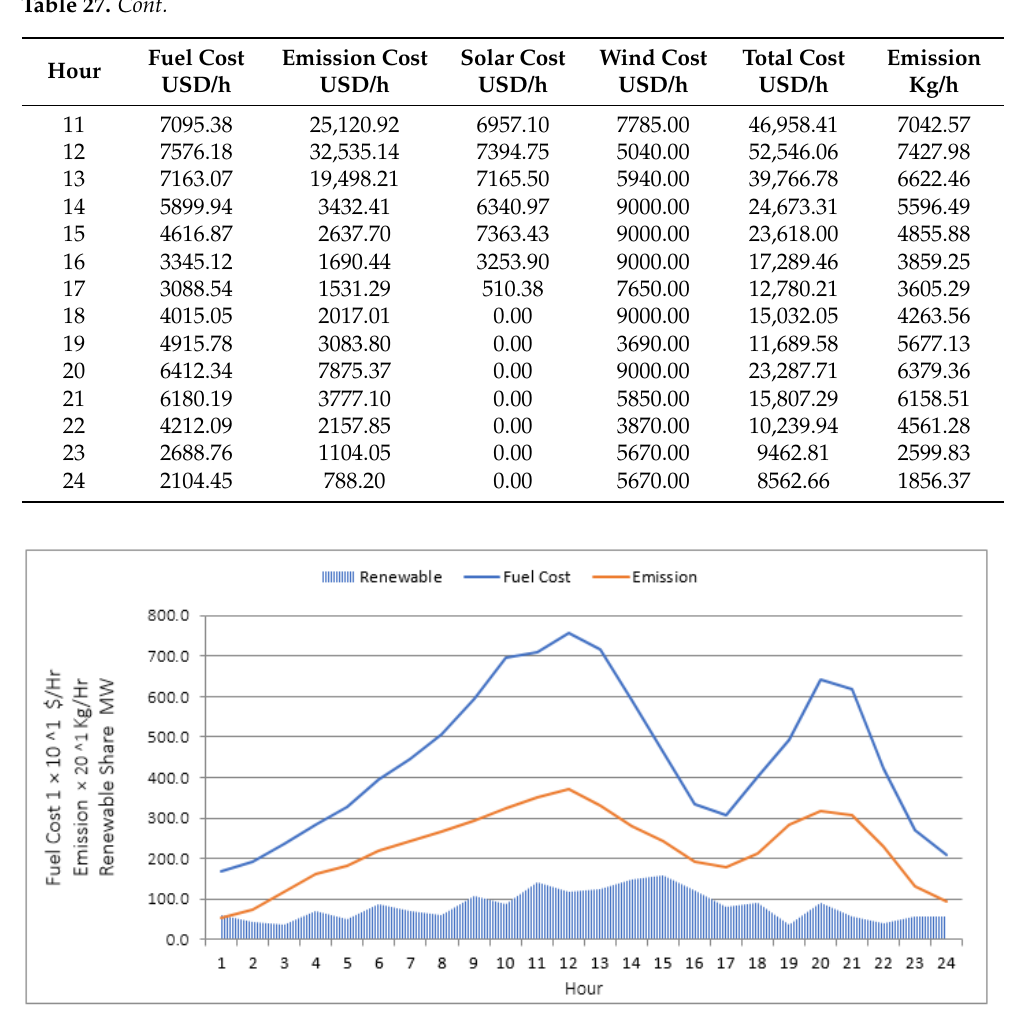
Figure 13. Effect of integrating RES on fuel costs and emissions—case study 3. Table 28. Fuel-cost comparison between CISSA and back-tracking algorithm.